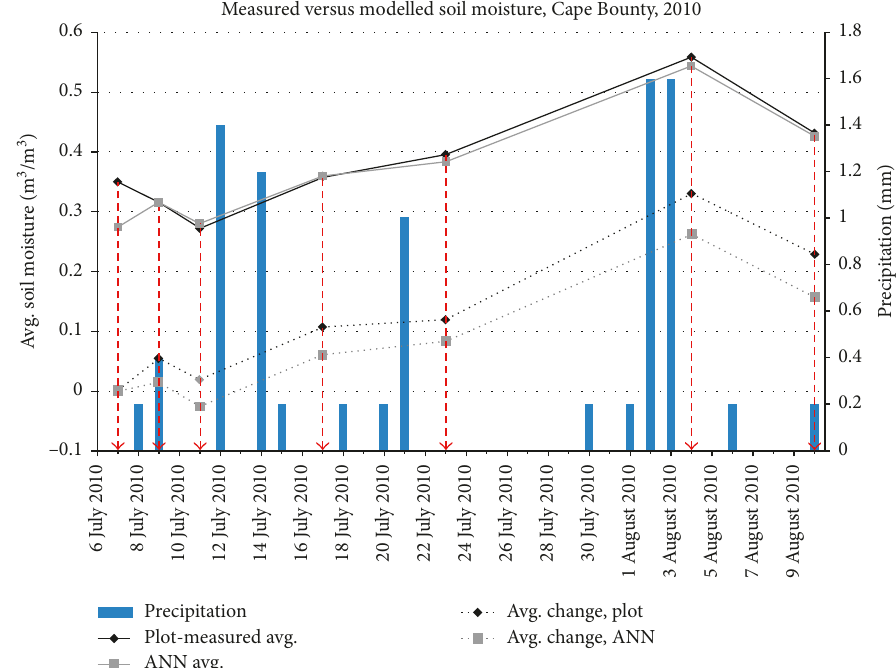
Figure 8: Precipitation and its effects on average soil moisture at the Cape Bounty Arctic Watershed Observatory, 2010. Arrows indicate RADARSAT-2 overpass dates. Plot-measured and ANN avg. values are average soil moisture values measured in the field at each date and the ANN output for that date, respectively. Avg. change values are differences in moisture between each date from a 0 start value (at July 7).